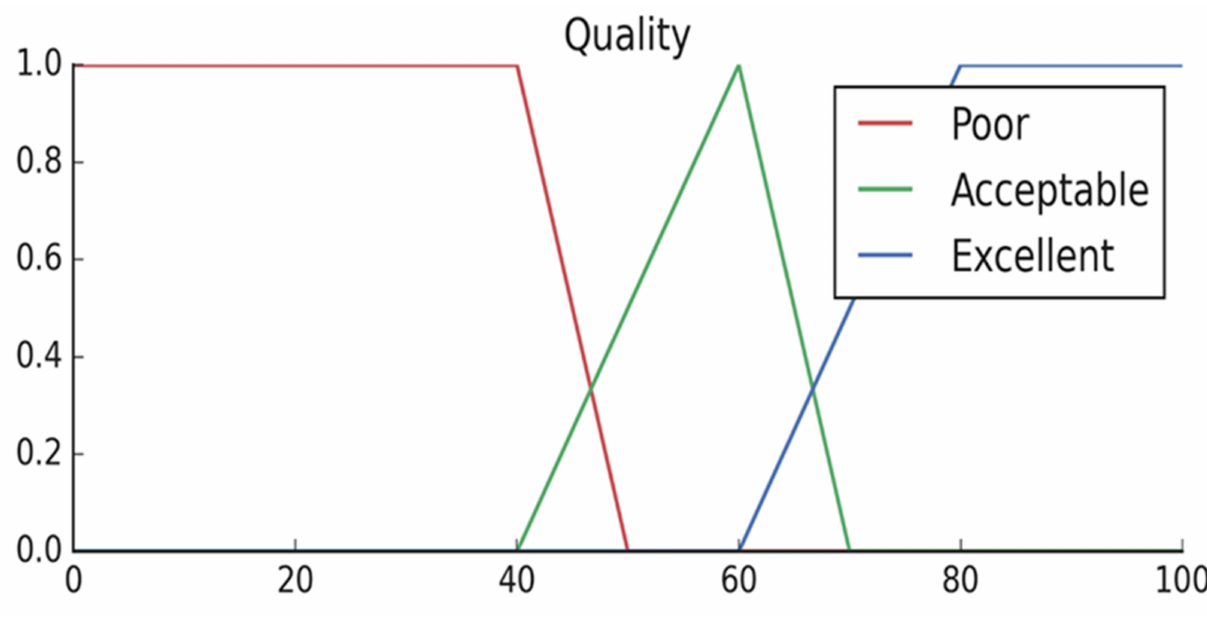
Figure 7. Membership of the